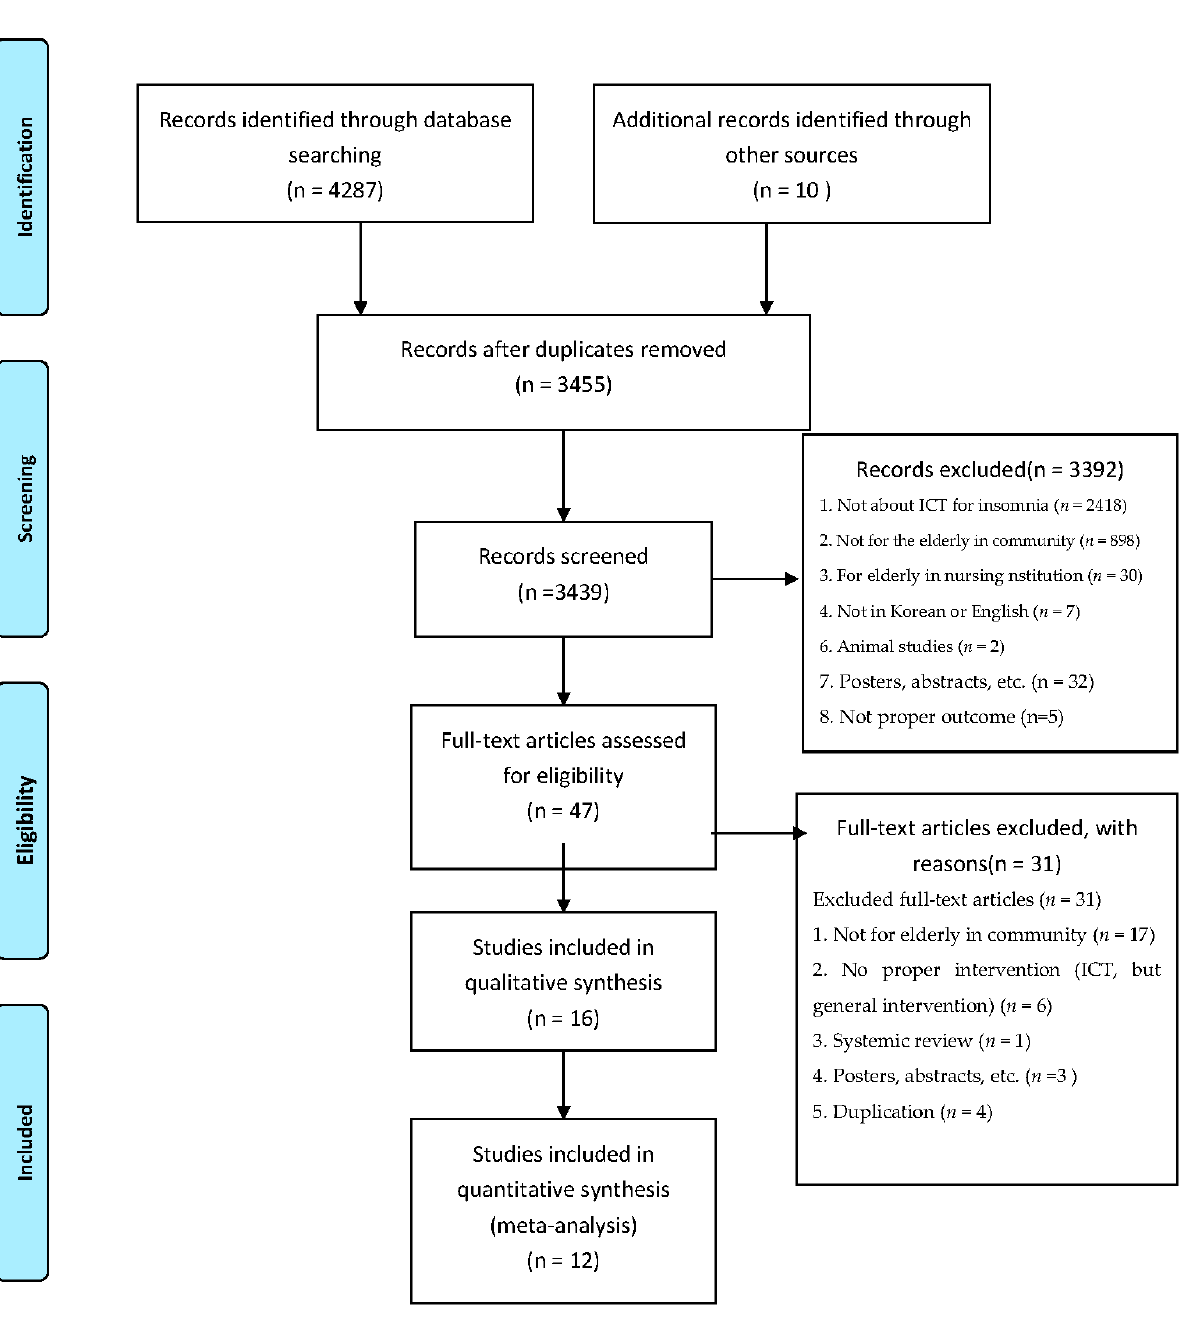
Figure 1. Flow chart of the study selection.